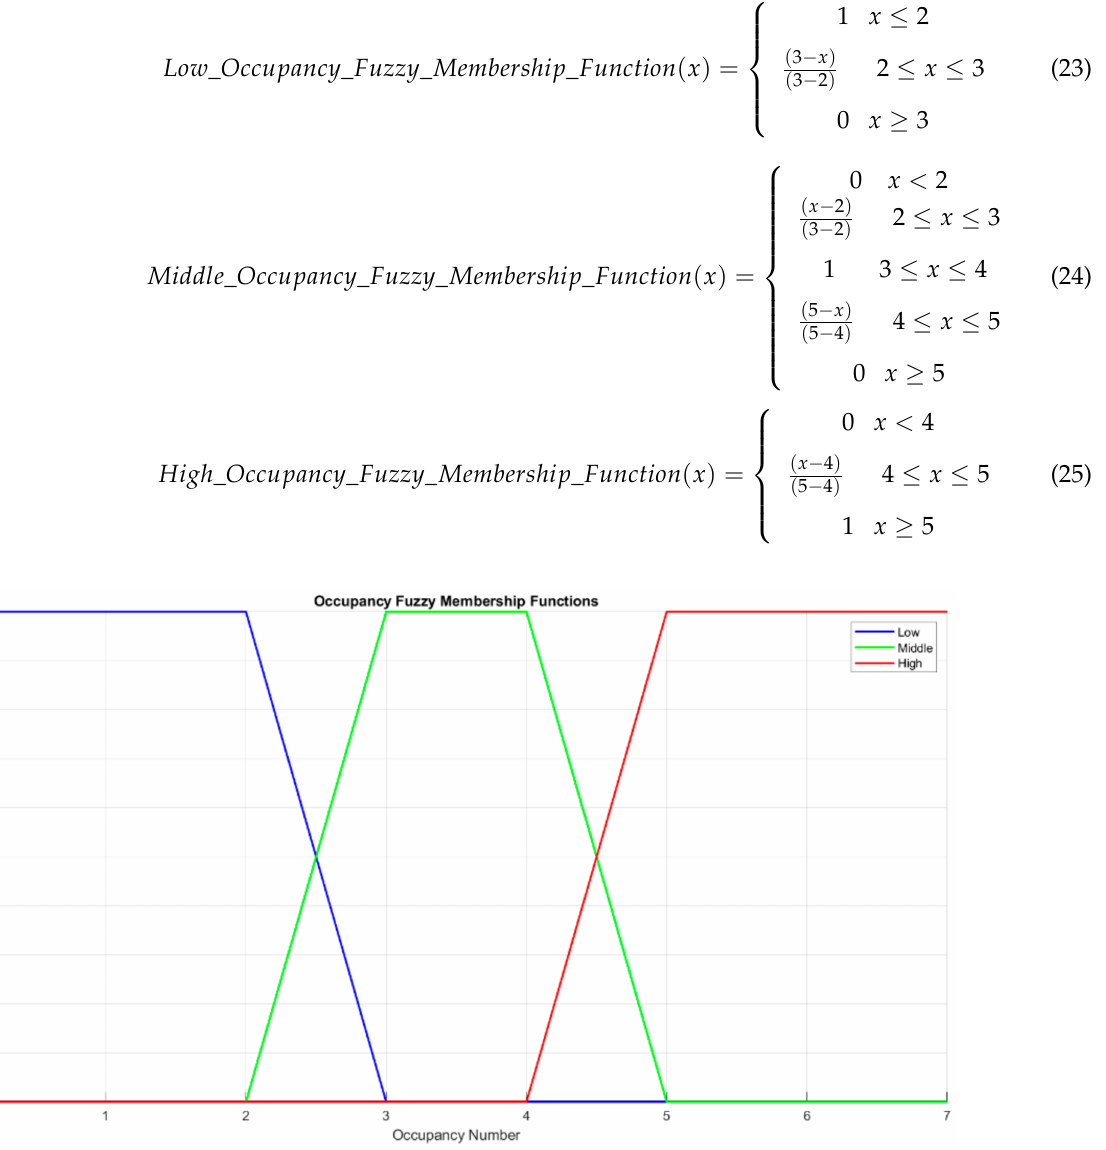
Figure 15. Occupancy fuzzy membership